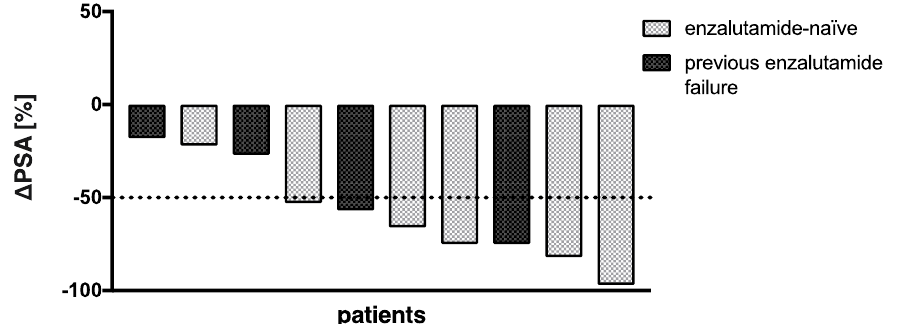
Figure 2. Waterfall plot of best PSA response to PSMA-RLT after start of enzalutamide medication.